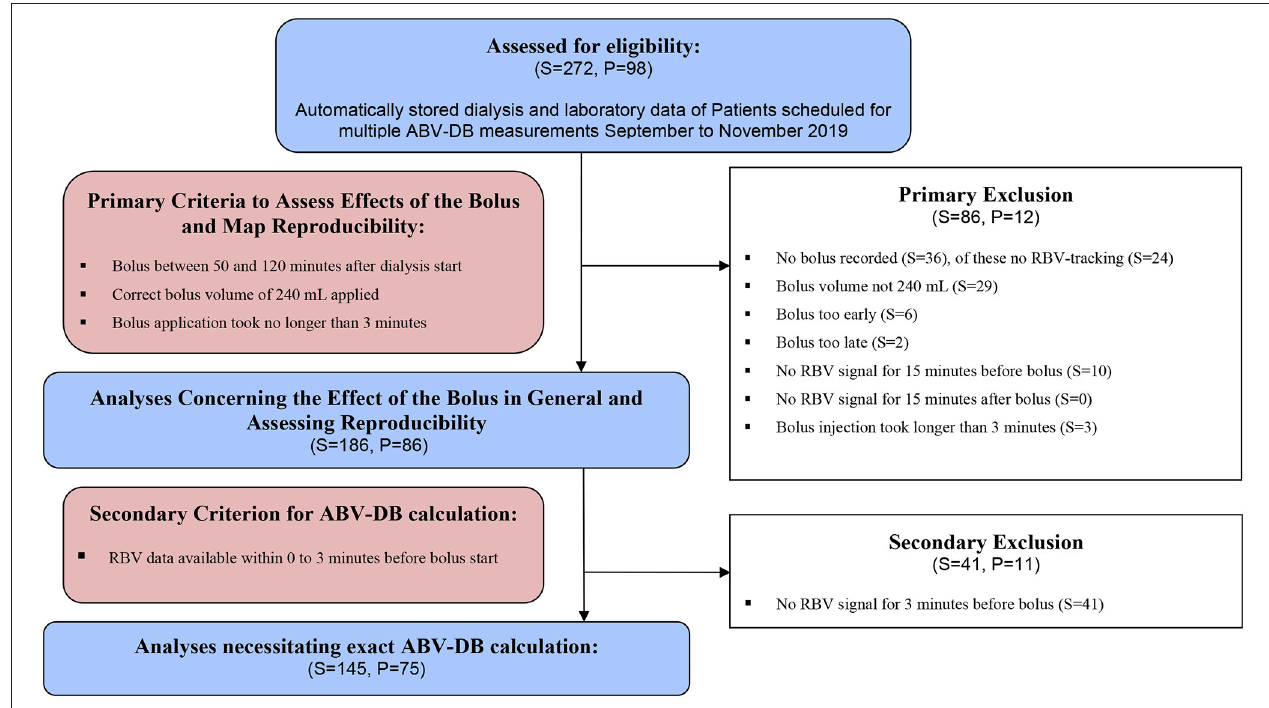
FIGURE 1 | Patient flow chart. S, Sessions; P,